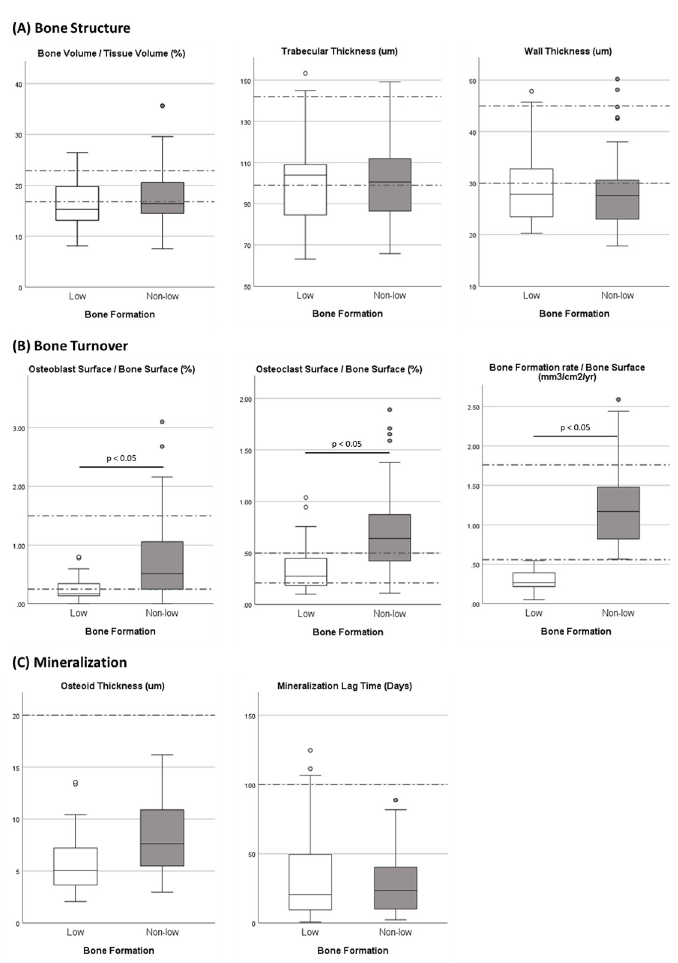
Fig 1. Boxplots of bone histomorphometric parameters of patients with low or non-low bone formation. Dashed grey lines denote normal ranges. (A) Parameters of bone structure. (B) Parameters of bone turnover. (C) Parameters of